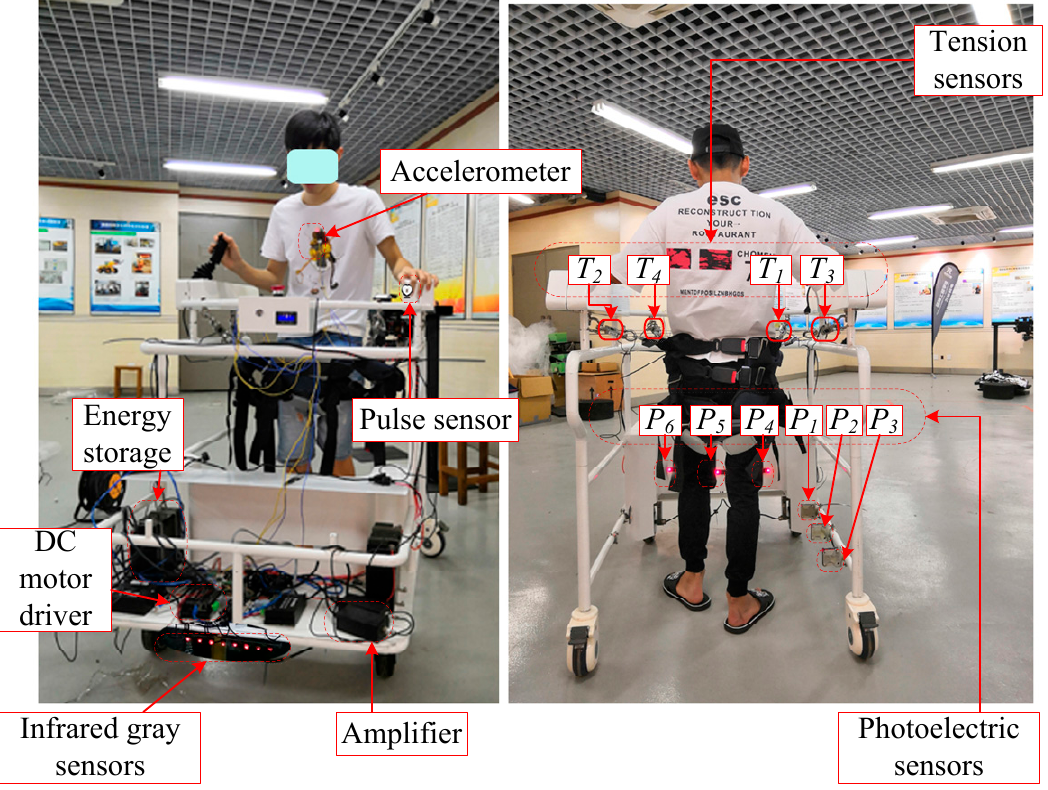
Figure 3. Multisensor fusion system.